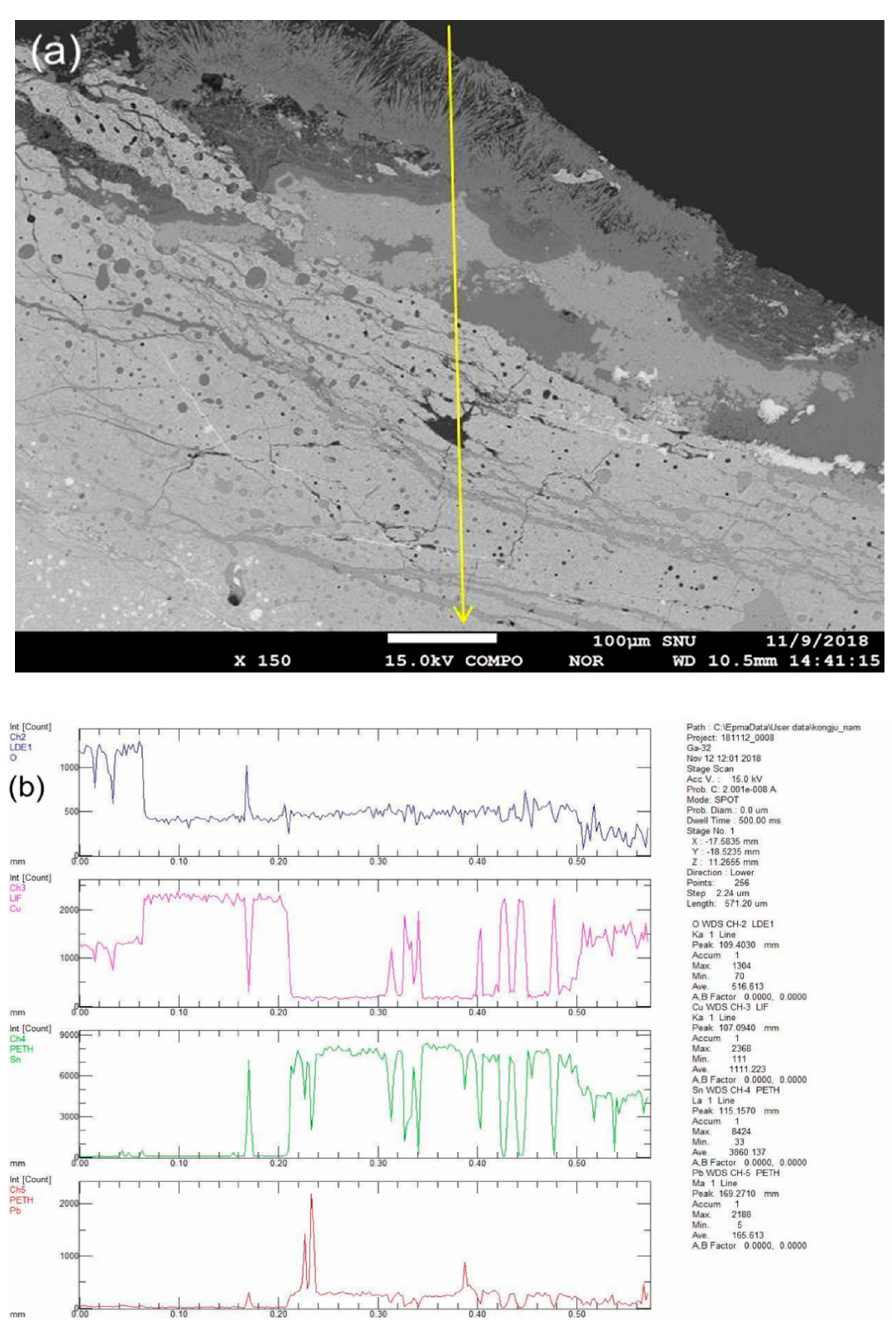
Figure 13. ( a ) Ga-35 (No. 3) electron probe microanalyzer (EPMA) image and ( b ) line